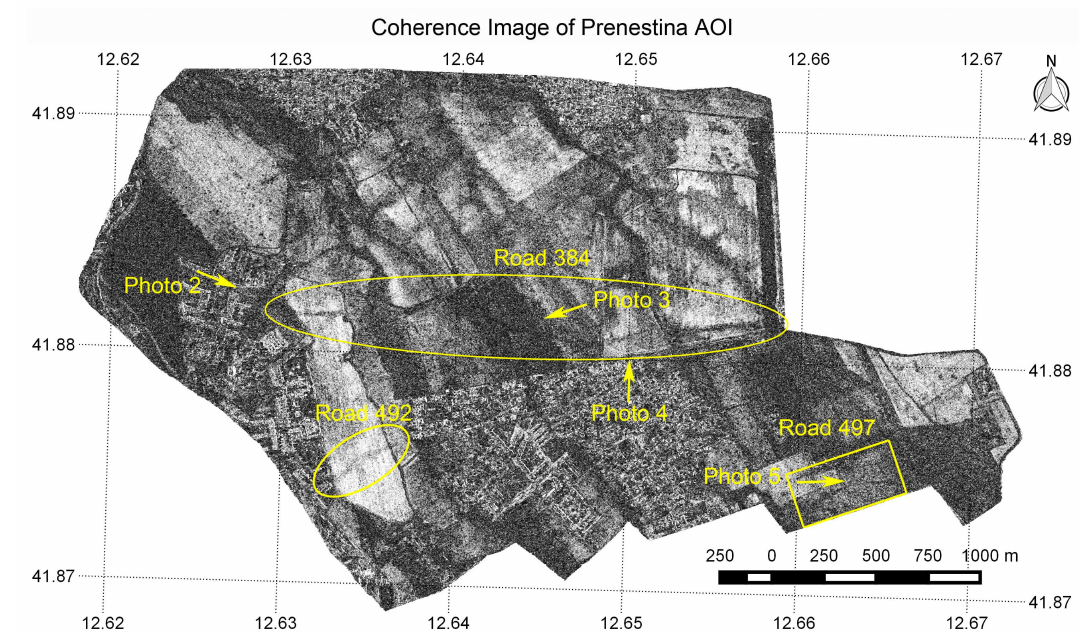
Figure 29. Coherence image from CSK Spotlight InSAR pair acquired on 9 and 25 July 2010 over the Prenestina AOI. Annotations in yellow show the locations of residues and the locations and directions from which photographs were acquired on the ground. COSMO SkyMed data provided by the Italian Space Agency.